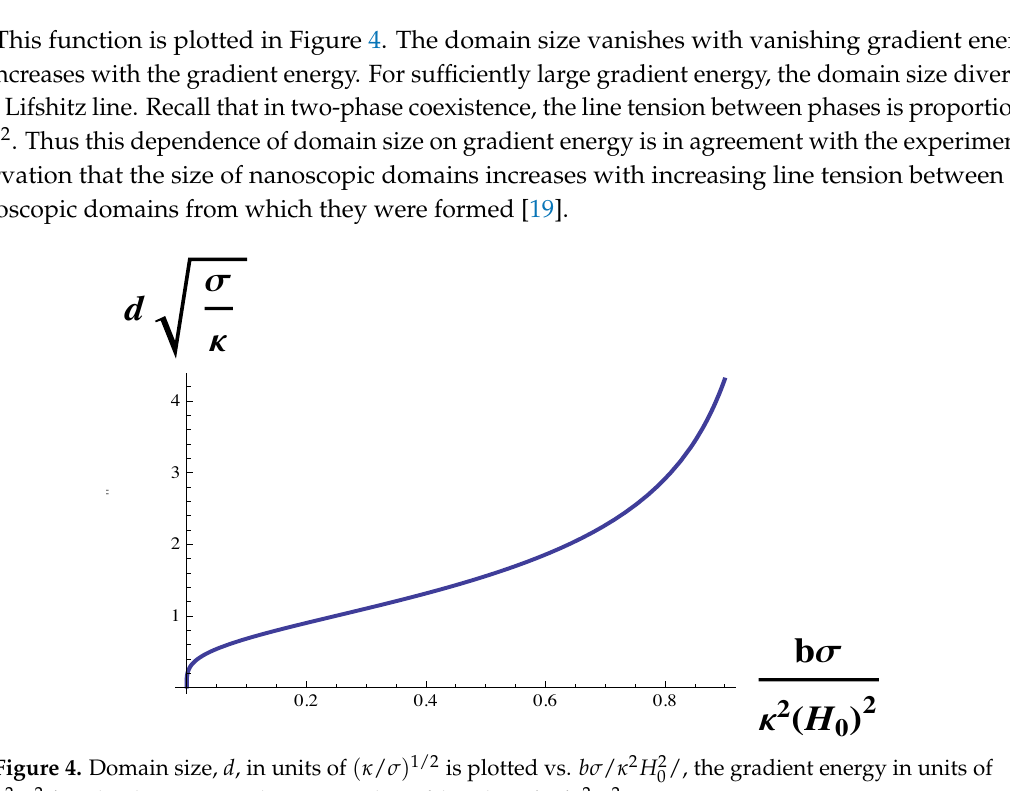
Figure 3. Domain size, d , in units of ( b / σ H 2 units of ( b σ ) 1/2 / H 0 . The domain size diverges at the Lifshitz line, κ H 0 / ( b σ ) 1/2 = 1.